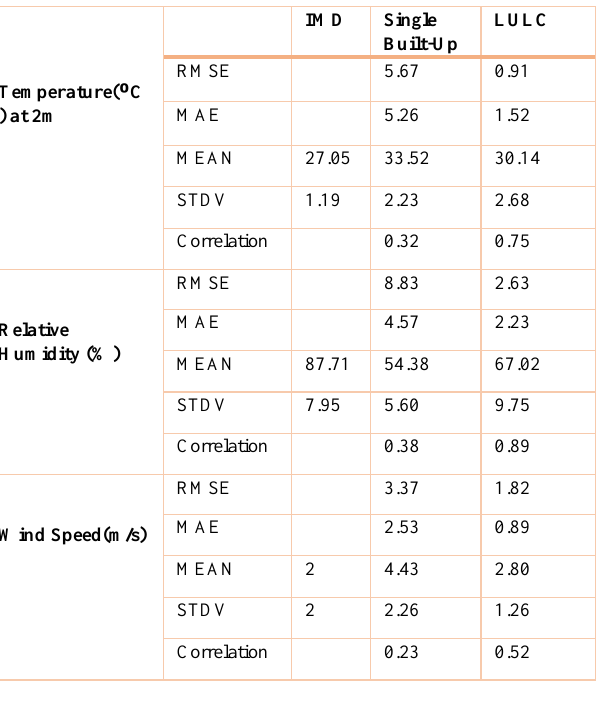
Table 4: Validation of the simulated results of T2,